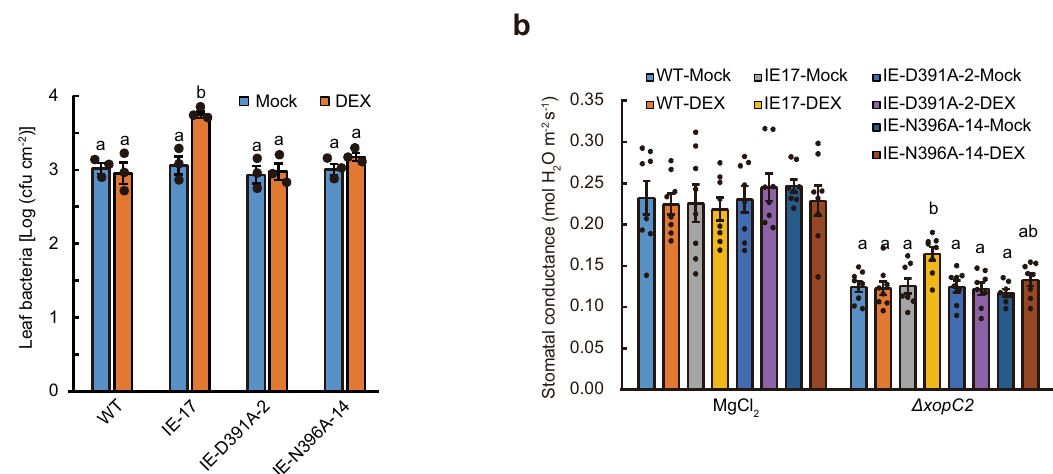
Fig. 2 XopC2 suppresses rice stomatal defense to promote X. oryzae pv. oryzicola infection. a Bacterial population sizes in the Δ xopC2 -inoculated leaves of the wild-type, IE-17, IE-D391A-2, and IE-N396A-14 transgenic seedlings. The 3-week-old seedlings were treated with mock and DEX followed by spraying with Xoc Δ xopC2 after 24 h. Bacterial populations were determined at 4 days post-inoculation (dpi). Data are shown as means ± standard error (SE) ( n = 3 technical replicates per measurement). The letters (a, b) indicate a statistically signi fi cant difference in bacterial population sizes as revealed by one-way ANOVA, Tukey ’ s honest signi fi cance test. b Stomatal conductance in the leaves of the wild-type, IE-17, IE-D391A-2, and IE-N396A-14 transgenic lines after challenging with Δ xopC2 . The 3-week-old seedlings were pretreated with DEX and mock followed by spray inoculation with Δ xopC2 and mock control. Stomatal conductance was measured at 2 dpi. Data are shown as means ± SE ( n = 8 technical replicates per measurement). These experiments were independently repeated 3 times with similar results in a and b . The letters (a, b) indicate a statistically signi fi cant difference in stomatal conductance of the xopC2 transgenic IE-17 seedlings between mock and DEX treatments as revealed by one-way ANOVA, Tukey ’ s honest signi fi cance compared with mock treatment (Supplementary Fig. 5c). In contrast, the SA and JA contents were not signi fi cantly different in mock-treated and DEX-treated wild-type and IE-17 lines (Supplementary Fig. 5d, e). In addition, either expression of OsICS1 and OsPAL1 (the SA-biosynthesis genes) or induced expression of OsIAA9 and D10 by auxin and strigolactone, respectively, was not altered in the IE transgenic lines after DEX treatment (Supplementary Fig. 5f – i). These results indicate that ectopically expressed XopC2 speci fi cally promotes JA signaling in rice.